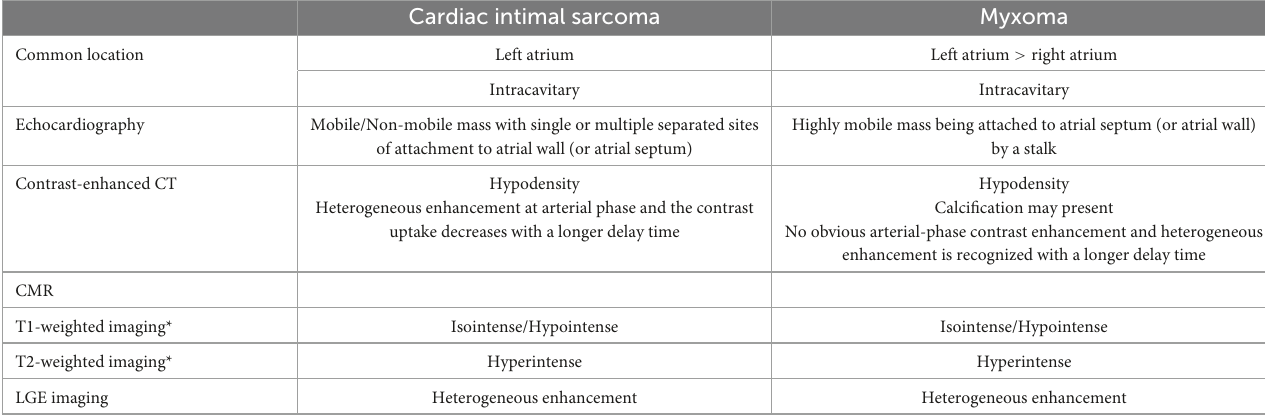
TABLE 1 Comparison of imaging characteristics of cardiac intimal sarcomas and